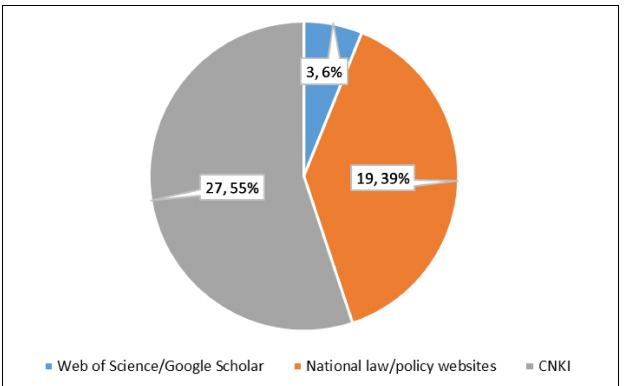
FIGURE 1 | Illustration of the number of articles, laws, and policies related to Chinese policy on IUU fishing.